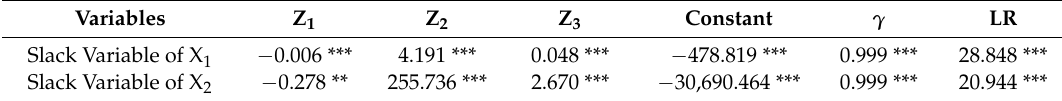
Table 6. Stage 2: Results of Stochastic Frontier Analysis (SFA) regression model. Variables Z 1 Z 2 Z 3 Constant Slack Variable of X